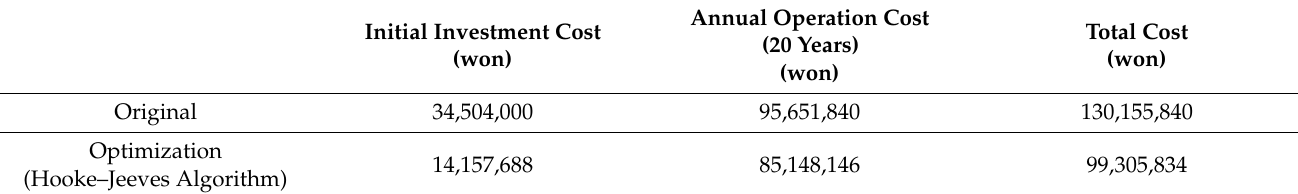
Table 7. Optimization results of